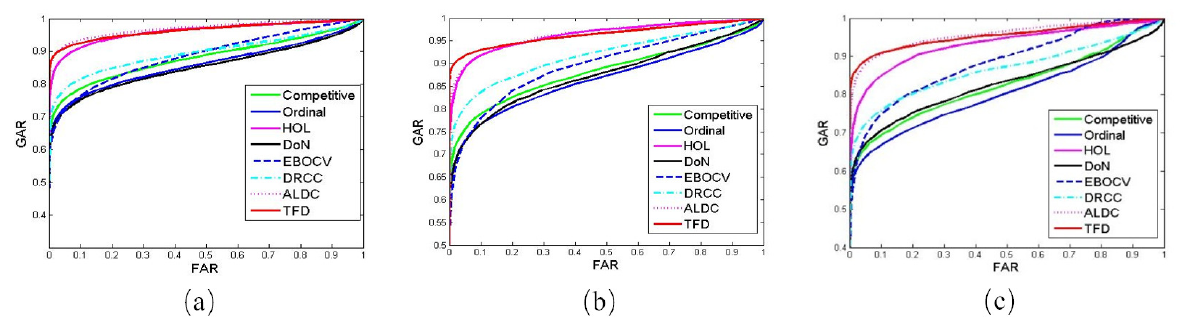
Figure 6. The ROCs of different methods on the ( a ) CASIA, ( b ) IITD, and ( c ) GPDS databases.